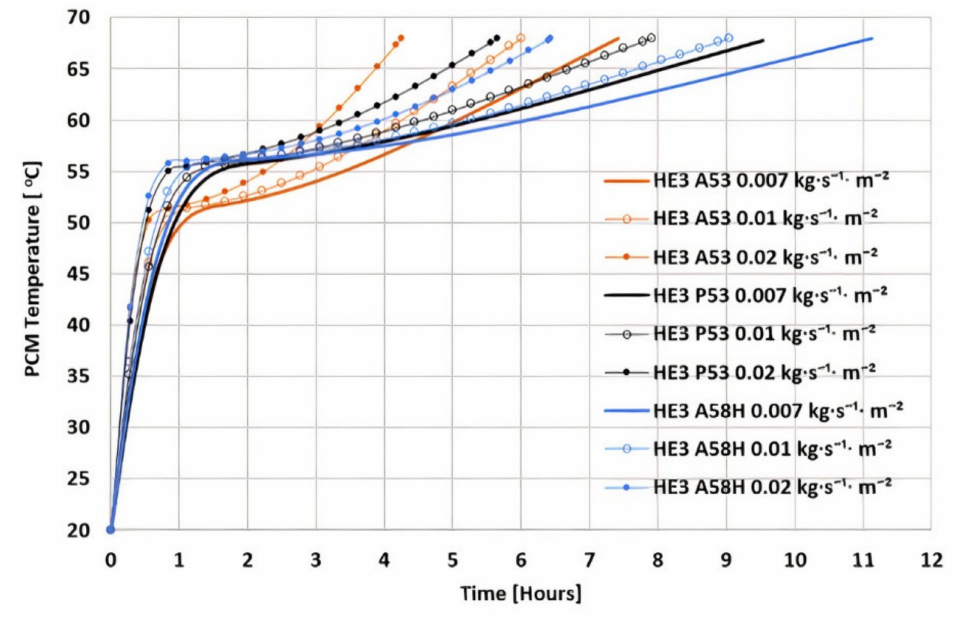
Figure 11. Area average temperature of PCM active volume during charging for all PCMs and all HTF flow rates, for